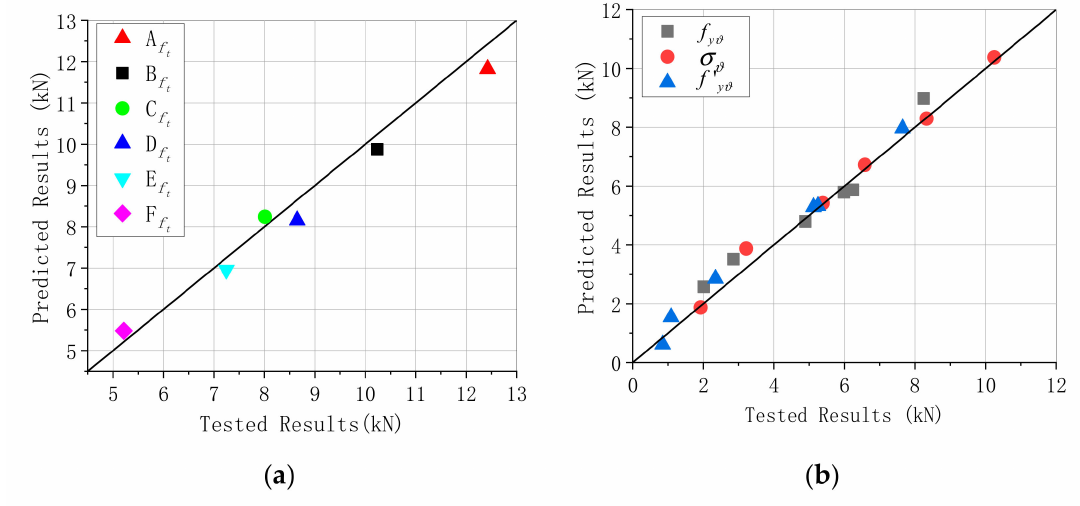
Figure 18. Comparison of the analytical and tested results. ( a ) Prestrengthening CFRP, ( b ) poststrengthening reinforced